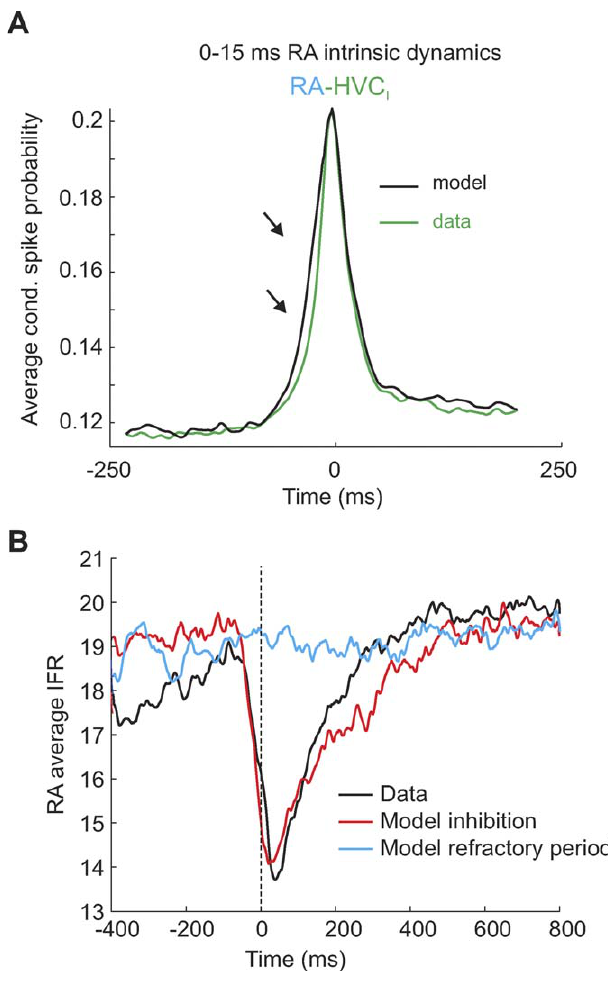
Figure 7. RA-Intrinsic Dynamics and Inhibition (A) When RA burst sequences extend beyond HVC I sequences by a random time uniformly distributed in the interval 0–15 ms, then the left flank of the average RA–HVC I CSP function gets uncharacteristically wide (arrows). (B) Transitive suppression of tonic firing in RA neurons is explained by RA inhibition. Shown are average RA IFR curves in 1.2 s time windows in which one RA neuron does not fire a burst, and time-aligned to burst onset in a simultaneously recorded RA neuron. Conjunctively with the bursts, there is a transient reduction in firing rate of the nonbursting neuron (black curve, n ¼ 50 RA neuron pairs). The model in which RA inhibition suppresses spontaneous firing (red curve) is able to reproduce this transient reduction, but the model in which RA neurons display a soft refractory period after bursts (blue curve) is not. p ¼ 6/7, q ¼ 39/40, L R ¼ 12, p R ¼ 1, D R ¼ 240 ms, and p b ¼